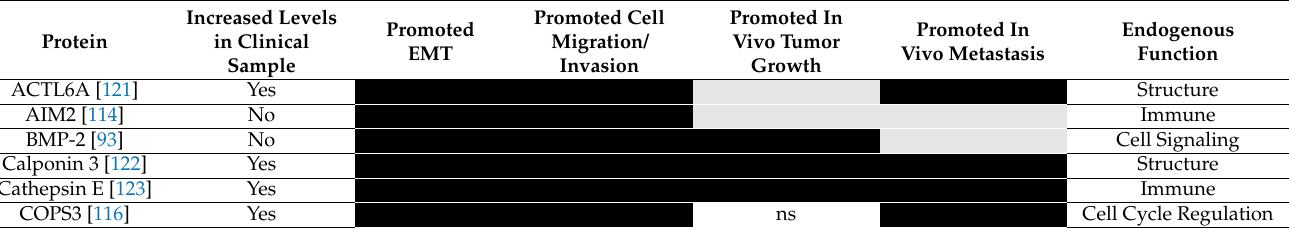
Table 1. Effects of highly expressed proteins on EMT in